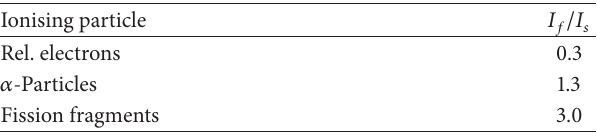
Table 1: Relative fast-to-slow signal intensity ratio in LAr for different particles in zero-field conditions [23]. LET increases from electrons to fission fragments, and 𝐼 𝑓 /𝐼 𝑠 increases as